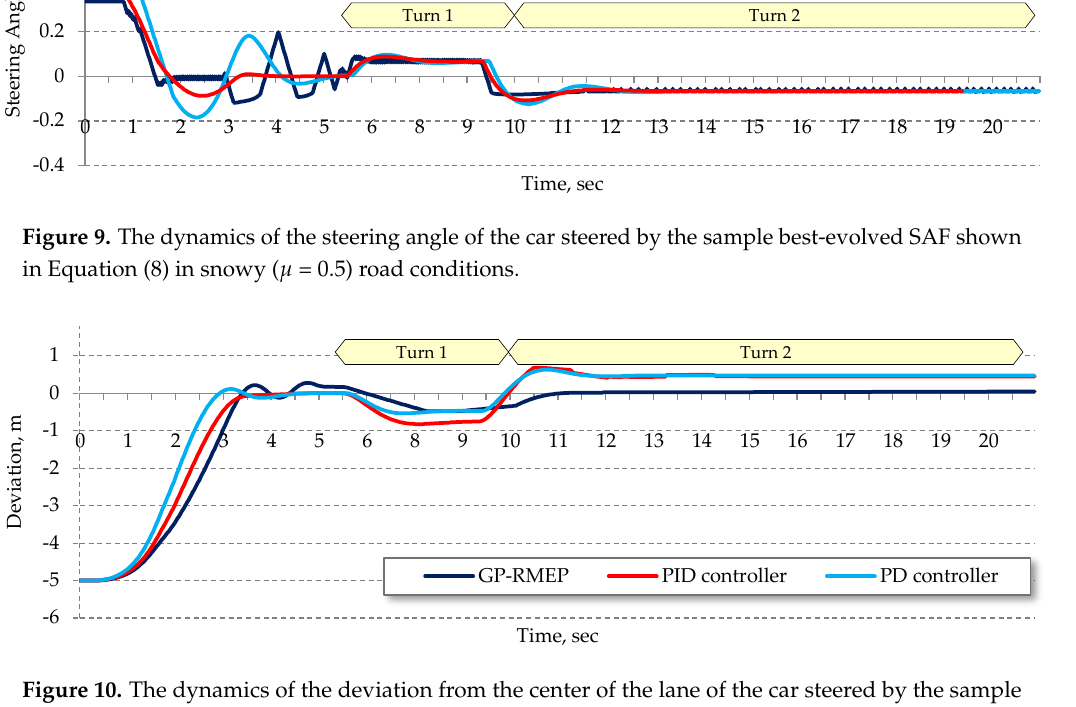
Figure 10. The dynamics of the deviation from the center of the lane of the car steered by the sample best-evolved SAF shown in Equation (8) in snowy ( µ = 0.5) road conditions.